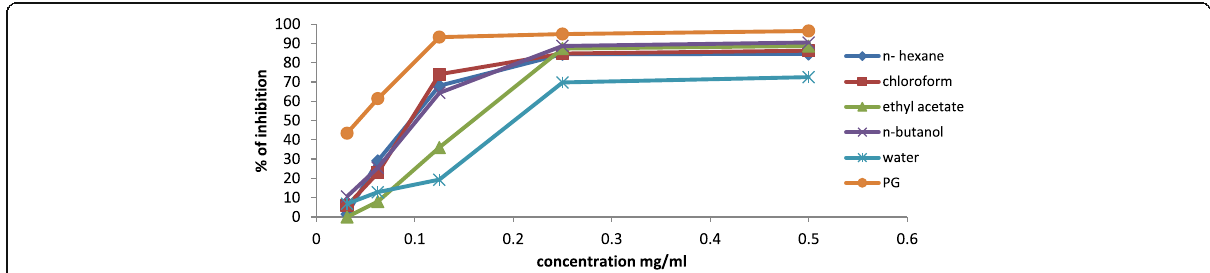
Fig. 4 Comparison Chart of Antioxidant potentials of S. latifolius fractions with the decrease of concentration (IC50